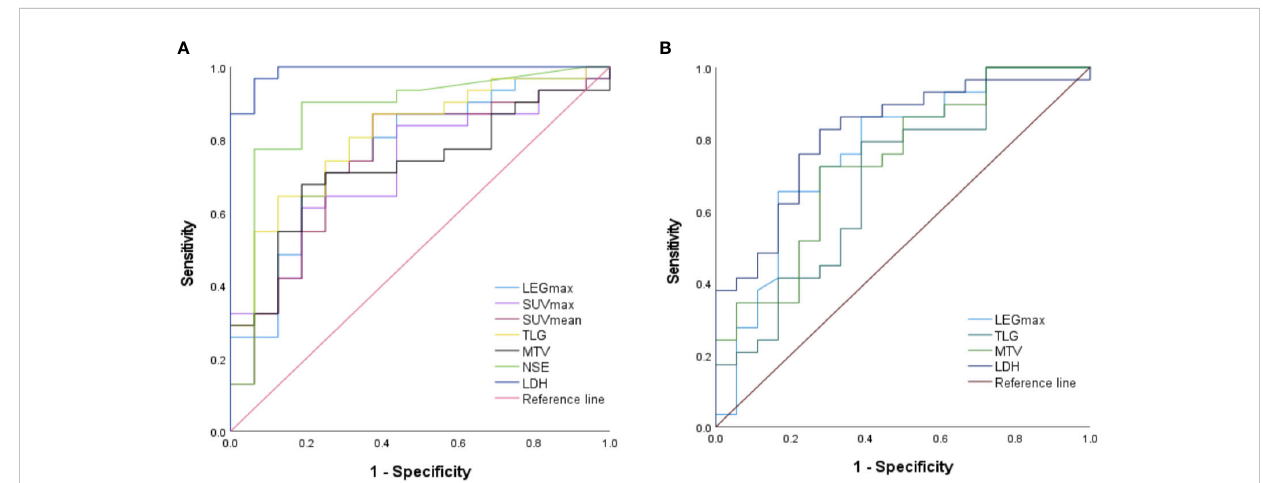
FIGURE 2 Performance of ROC curves predict the (A) MYCN gene ampli fi cation and (B) chromosome 1p36